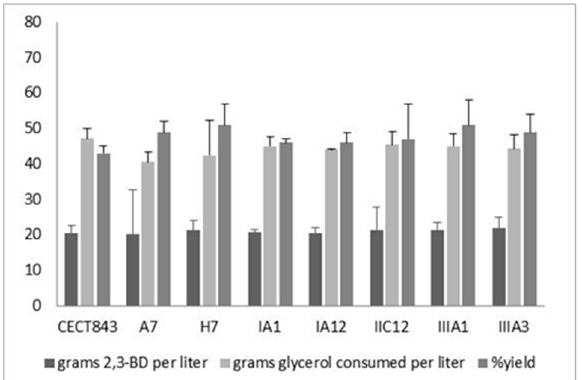
Figure 2. Comparison of wild-type and mutant strains obtained by random mutagenesis. Twenty-four strains were tested in a micro-reactor with medium MB and 3 mL of work volume (see Material and Methods section) but strains A7, H7, IA1, IA12, IIC12, IIIA1 and IIIA3 showed the best yields.